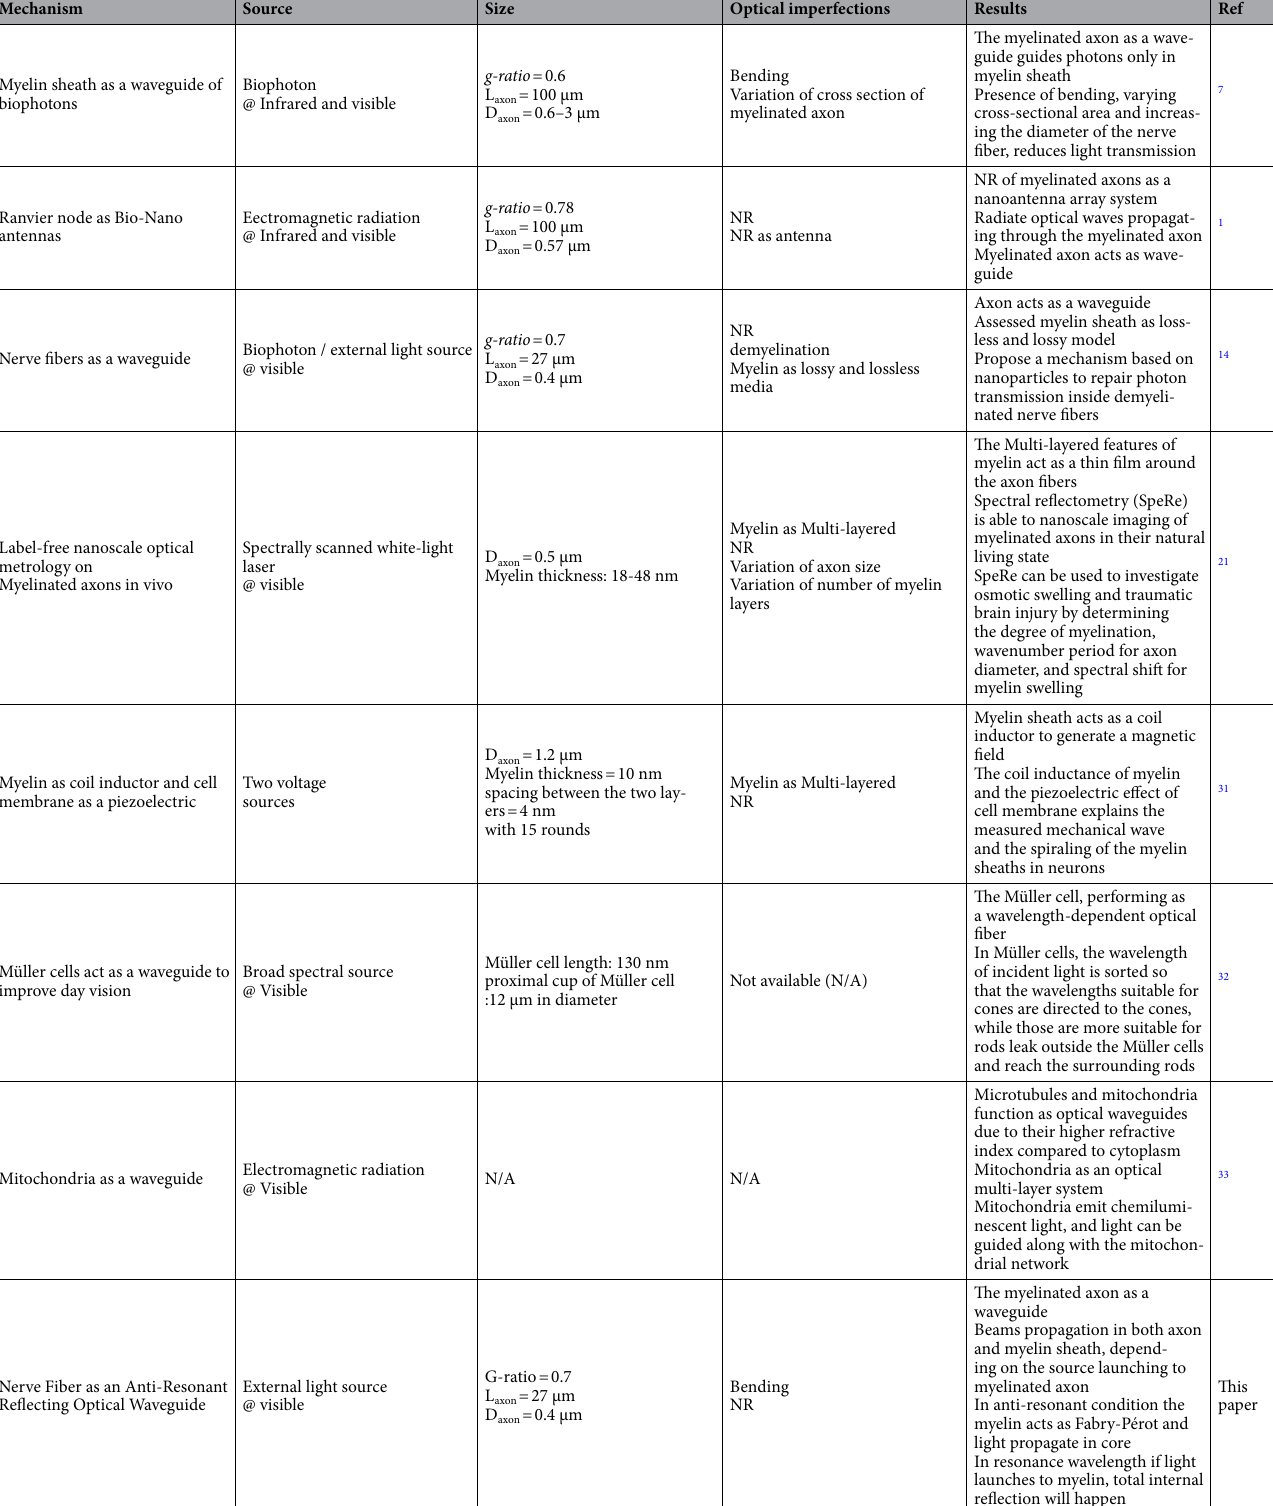
Table 1. A review of the researches on transmission of light in nerve